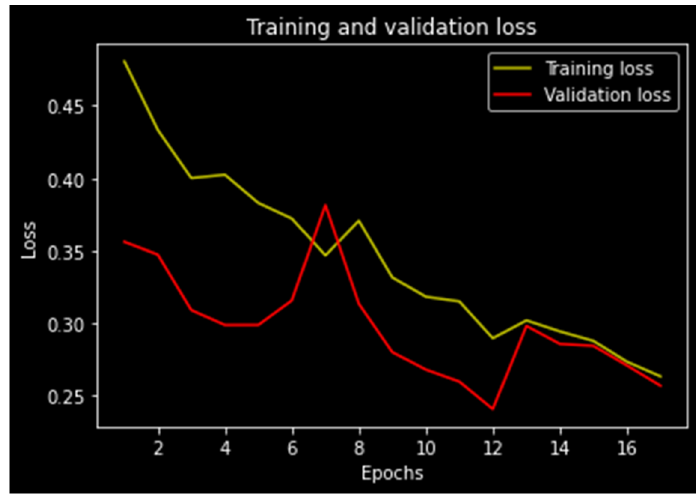
Figure 5. Overall training and validation loss of the proposed model.